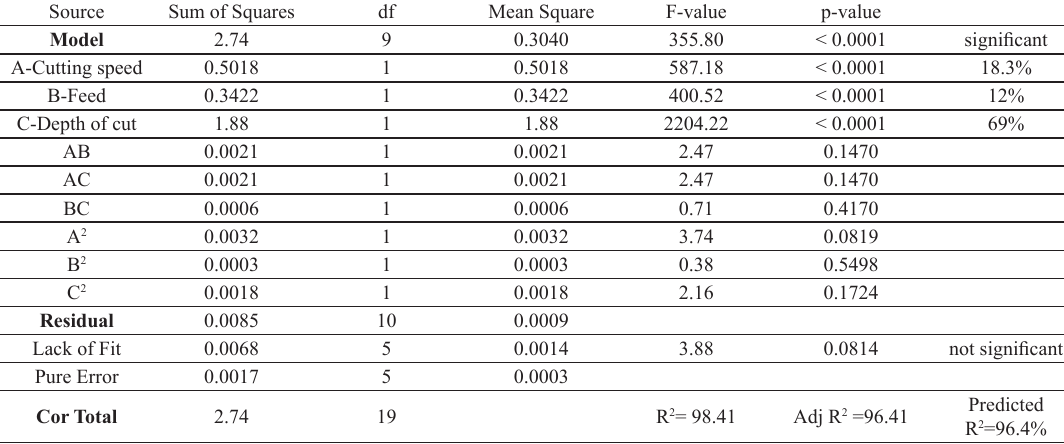
Table 7. ANOVA for prediction of surface